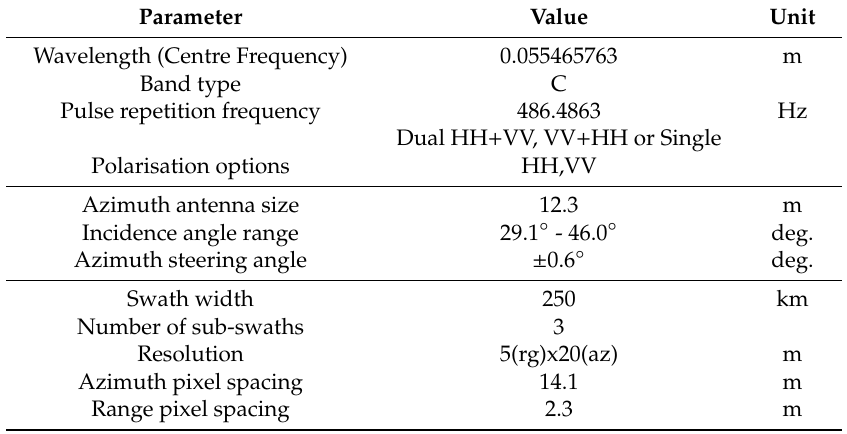
Table 3. Sentinel-1 operational parameters in interferometric wide (IW) acquisition